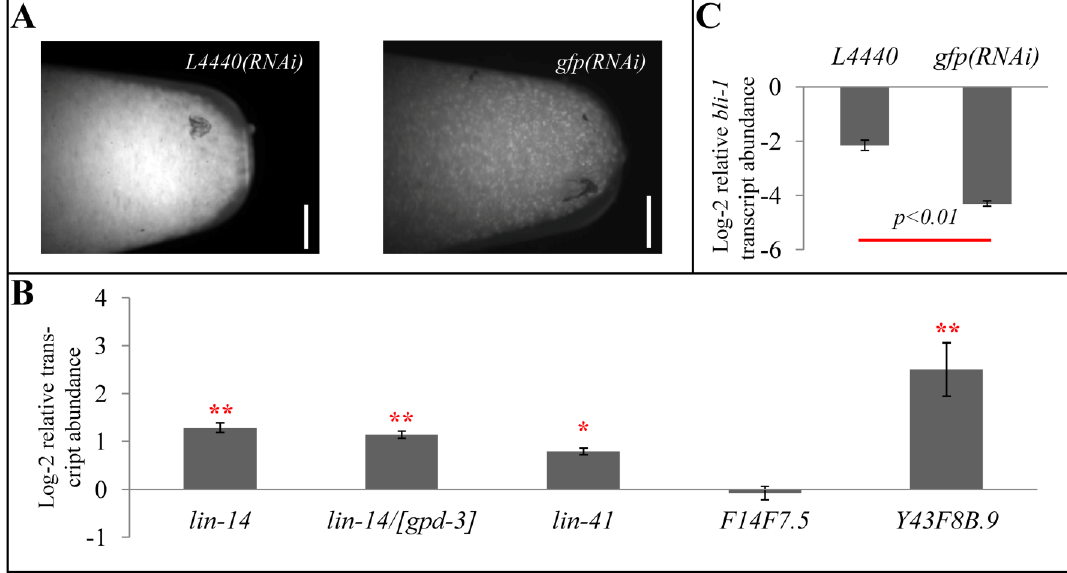
Figure 4. The effect of exogenous RNAi on transcript abundance of miRNA- and endo-RNAi-regulated genes. (A) Photomicrograph of ~200 µL of sur-5::gfp animals grown on control (empty L4440 vector) or gfp(RNAi) bacteria prior to RNA extraction. Scale bar indicates 1 mm. (B) bli-1 normalized relative lin-14 , lin-41 , F14F7.5 , and Y43F8B.9 transcript levels in mid-L4 (69 hours post hatching at 15 °C) gfp(RNAi) -treated sur-5::gfp animals compared to L4440 vector-fed sur-5::gfp animals. gpd-3 normalized lin-14 transcripts in mid-L4 gfp(RNAi) -treated sur-5::gfp animals compared to L4440 vector-fed sur-5::gfp animals is indicated by (cid:179) lin-14 /[ gpd-3 (cid:64)(cid:180)(cid:17)(cid:3) (C) gpd-3 normalized relative bli-1 transcript levels in mid-L4 gfp(RNAi) -treated sur-5::gfp animals compared to L4440 vector-fed sur-5::gfp animals. * indicates p < 0.05; ** indicates p < 0.01; no asterisks indicate statistical insignificance. p -values are calculated by t